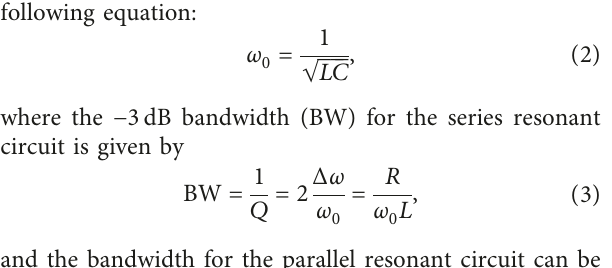
Figure 7: Equivalent circuit model of the WLAN/WiMAX triband compact printed